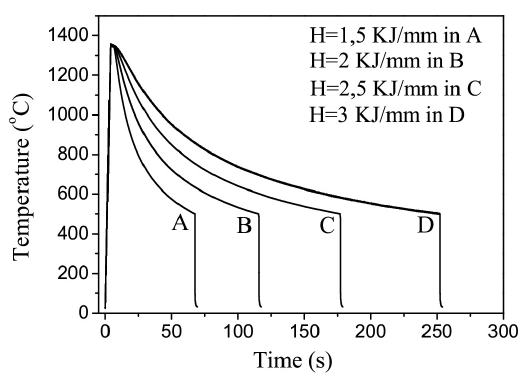
Figure 1. The Gleeble simulated thermal cycles corresponding to different heat inputs (H). The heating rate was 350 ºC/s and the corresponding cooling rates between 1350 ºC and 500 ºC were 13.8 ºC/s(A), 7.8 ºC/s(B), 5 ºC/s(C) and 3.5 ºC/s(D) respectively. (Morales et al. 19